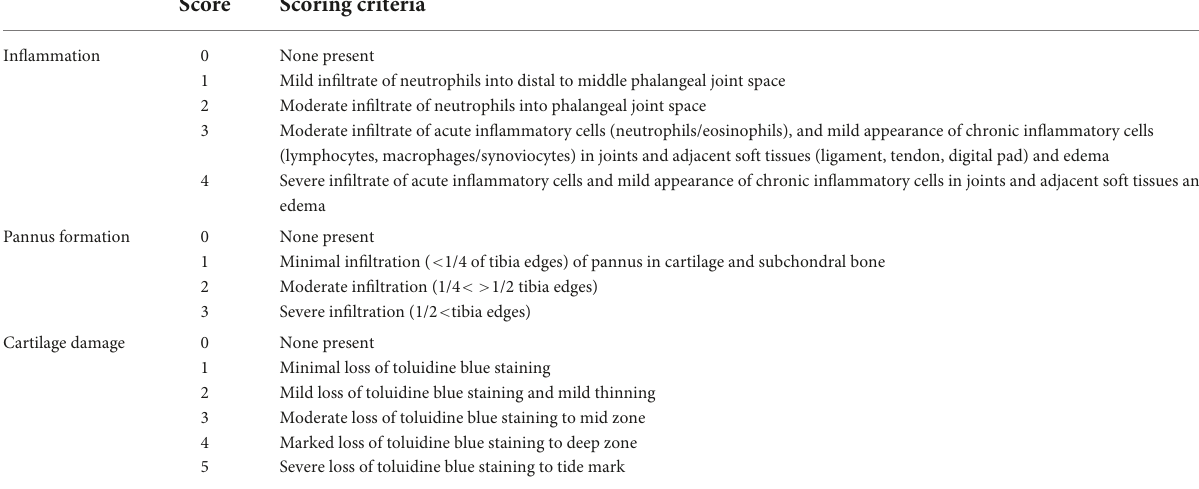
TABLE 1 Histological scoring of inflammation, pannus formation, and cartilage damage. Score Scoring